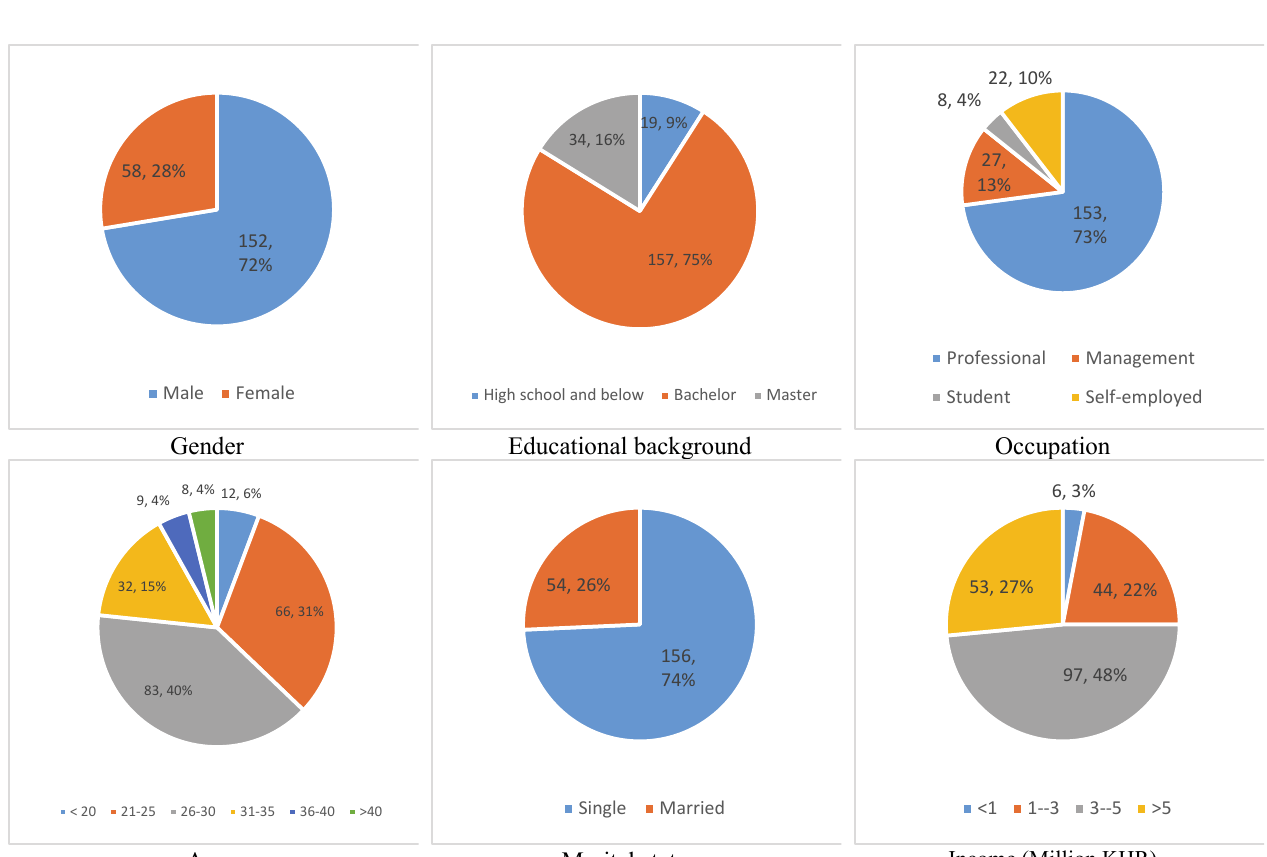
Fig. 2. Payment usage description